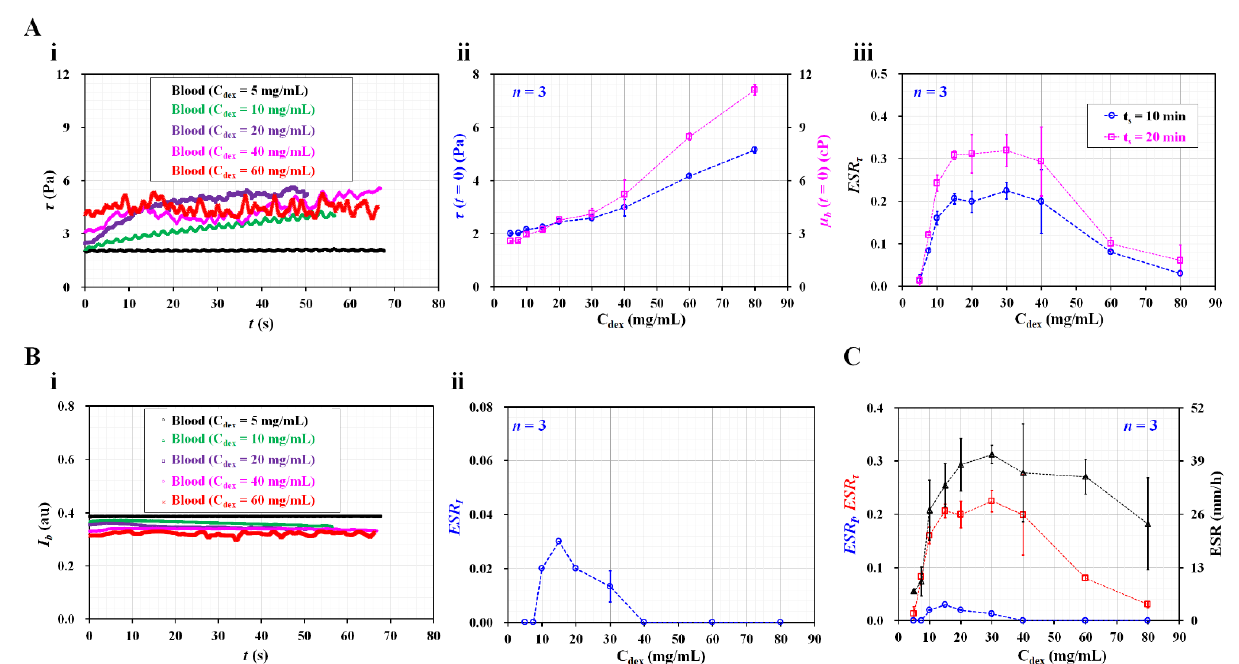
Figure 5. Quantitative comparison between present method and previous methods. ( A ) Contribution of dextran solution to RBC sedimentation index. ( i ) Temporal variations of shear stress with respect to C dex . ( ii ) Variations of initial shear stress (τ ( t = 0)) as well as blood viscosity ( µ b ( t = 0)) with respect to C dex . ( iii ) Variations of RBC sedimentation index with respect to C dex and t s . ( B ) Evaluation of RBC sedimentation using image intensity of blood flow ( I b ). ( i ) Temporal variations of I b with respect to C dex . ( ii ) Variations of ESR I with respect to C dex . ( C ) Quantitative comparison of RBC sedimentation index in terms of shear stress, image intensity, and sedimentation velocity.